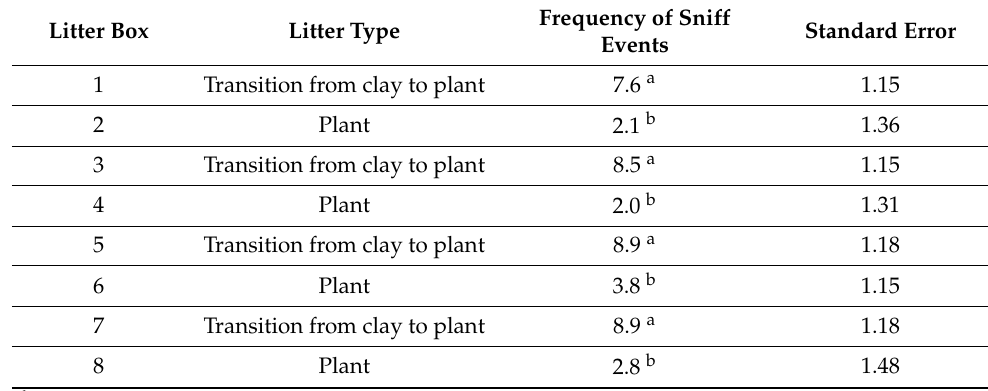
Table 2. Frequency of sniff events per litter box over the 6-day transition period.